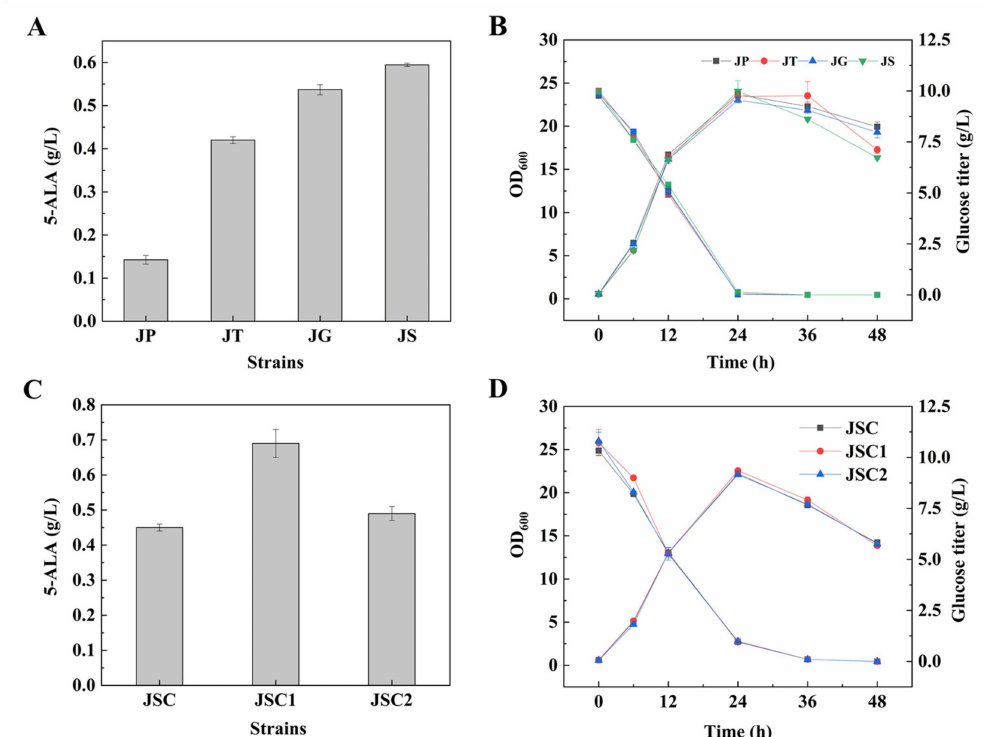
Figure 1. 5-ALA titer ( A ), cell growth, and sugar consumption ( B ) of strains JP, JT, JG, and JS overexpressing hemA RP from pXK-based plasmids under the control of promoters P pgk , P tuf , P glyA , and P sod(C131T) , respectively. 5-ALA titer ( C ), cell growth, and sugar consumption ( D ) of NCgl0580 and NCgl2065 overexpression strains JSC1 and JSC2, as well as JSC (control). Error bars represent the standard deviations from three independent